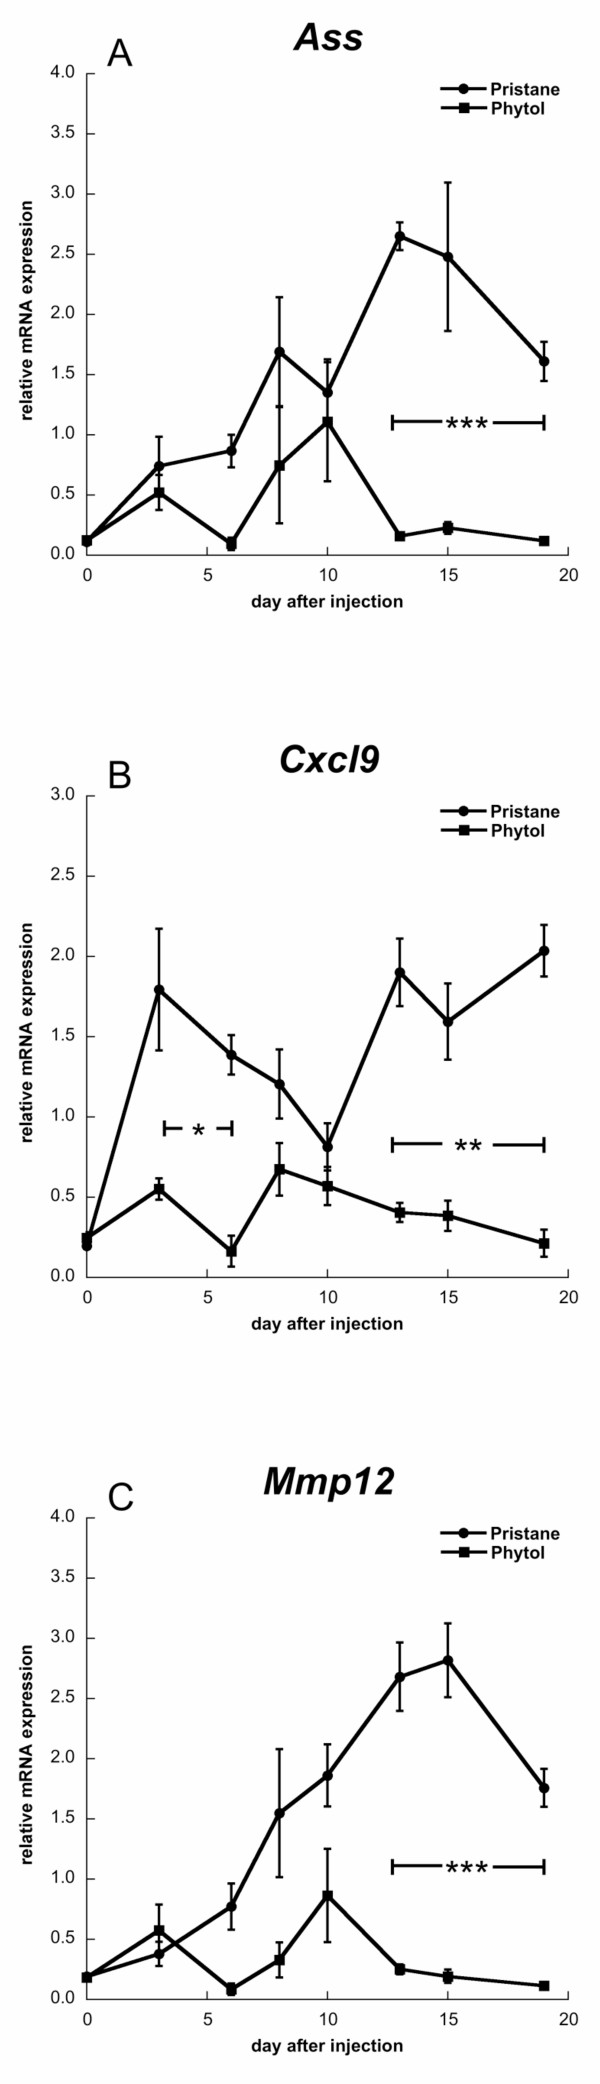
The relative mRNA expression of (A) Ass, (B) Cxcl9 and (C) Mmp12 in lymph nodes at 0, 3, 6, 8, 10, 13, 15 and 19 days after injection with pristane (circles) or phytol (squares). Values are means ± SEM from groups of four animals. Levels of significance were calculated using Student's t-test (*p < 0.05; **p < 0.01; ***p < 0.001).